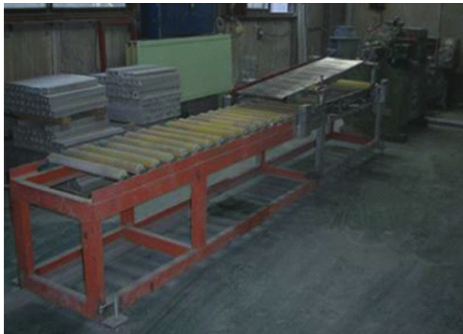
Figure 1: Extrusion equipment.